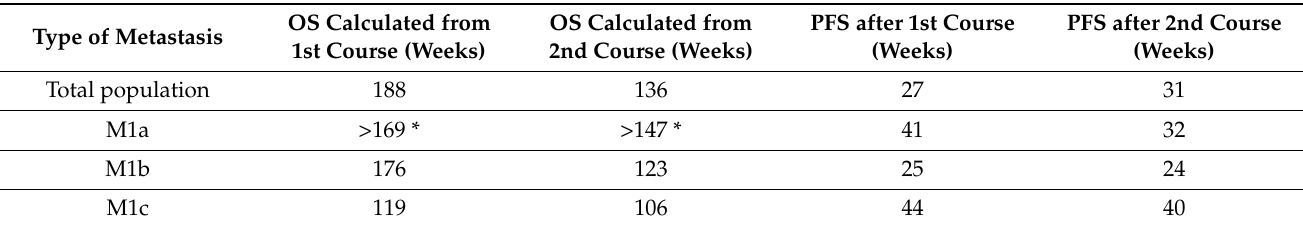
M1a: patients with lymph node metastasis; M1b: patients with bone ± lymph node without visceral metastasis; M1c: patients with visceral metastasis; OS: overall survival; PFS: progression-free survival; (*): no patient died in this group during follow-up.